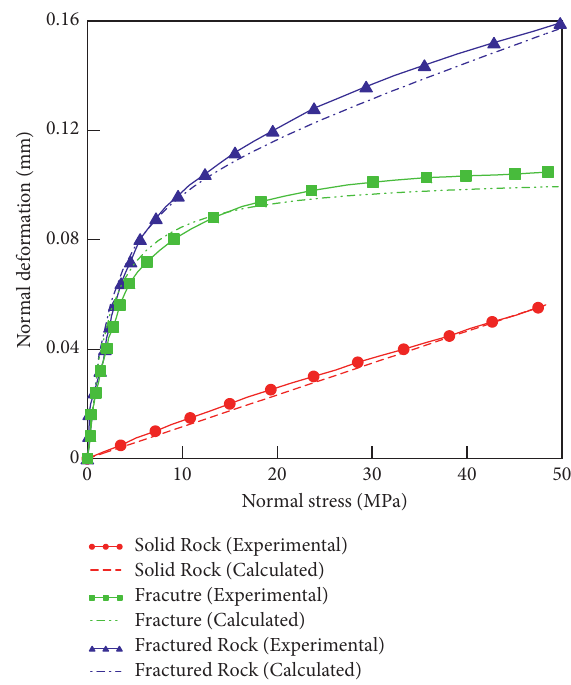
Figure 3: Validation of the fractured rock geomechanics